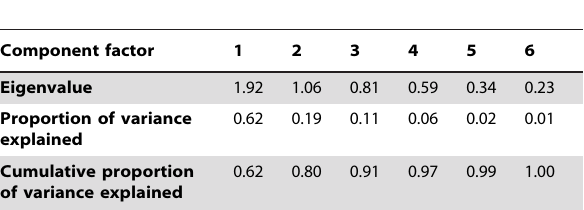
Table 2. Summary of PCA on 6 stomach temperature variables associated with PDER events ( n =1269) recorded in nursed harbour seal